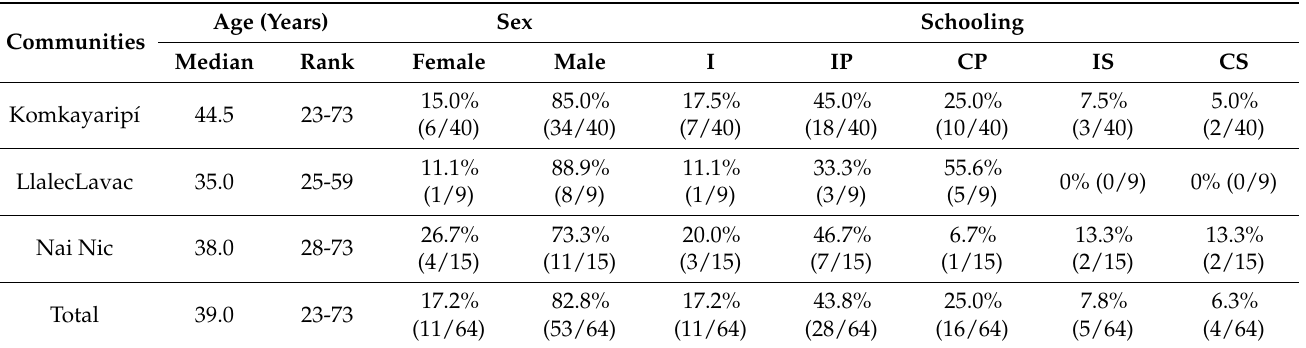
Table 2. Age, sex, and level of schooling of the head of household by community. Indigenous communities of the southern Chaco